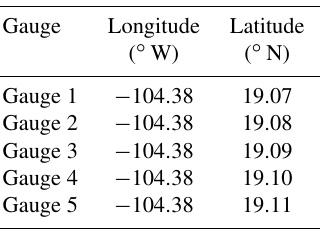
Table 10. Location of virtual gauges in the